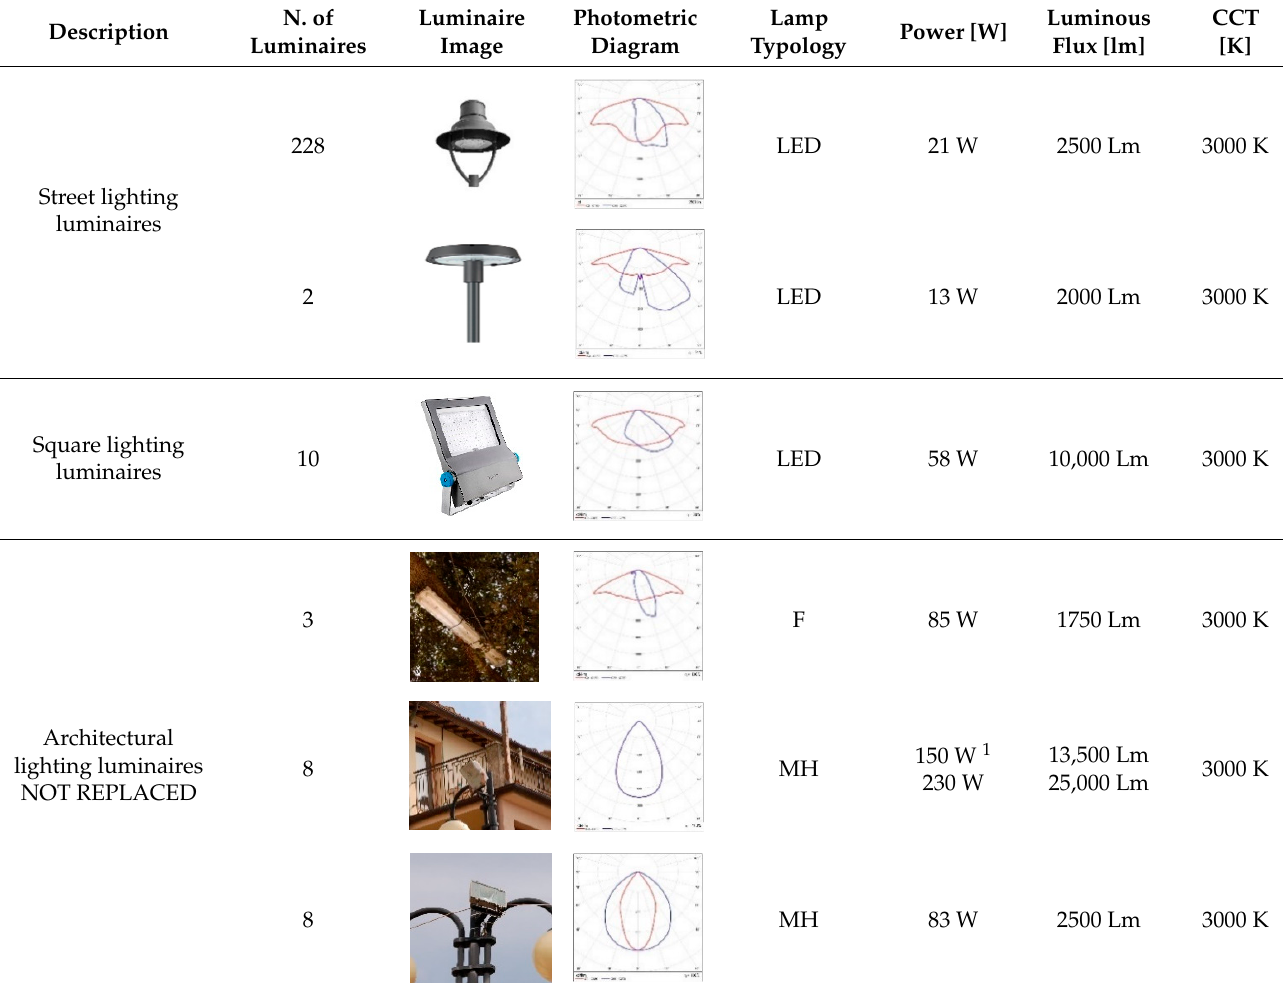
Table 2. Ex-post lighting